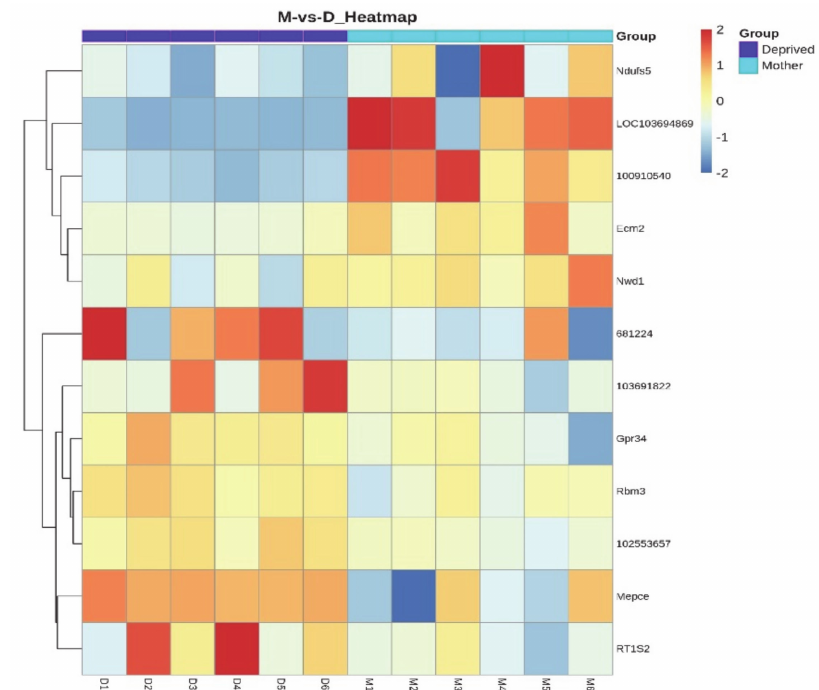
Figure 3. Differentially expressed genes in preoptic samples of mothers (M) and pup-deprived controls (D) are presented in a heatmap. The samples are shown horizontally, the DEGs are in Y axis. The color indicates the log10 transformed gene expression. Darkness means higher expression